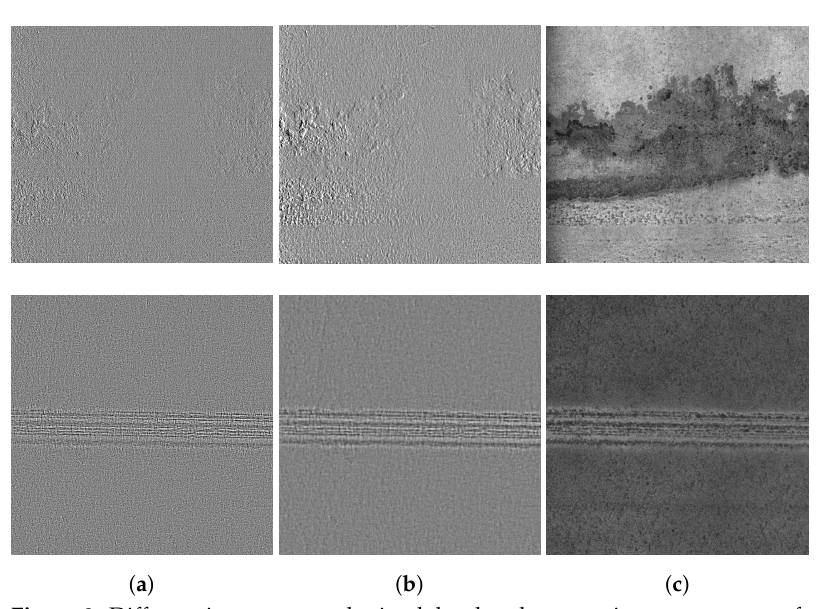
Figure 3. Different image types obtained by the photometric-stereo system of two different steel sheet samples (one sample in each row); ( a ) curvature image; ( b ) range image; and ( c ) texture image. From Figure 3, it can be ascertained that each of the three images is suitable for detecting a specific type of defect. Therefore, the system provides the necessary visual information to reveal different imperfections that may be present in the surface of the galvanized steel products. We propose to combine these three single channel images in a RGB format or three layer based images in which each layer corresponds to one such image, i.e., red channel corresponds to curvature image, green channel corresponds to range image, and, finally, the blue channel stores the texture image. In this way, we are collecting the information given by each individual image in one single image.